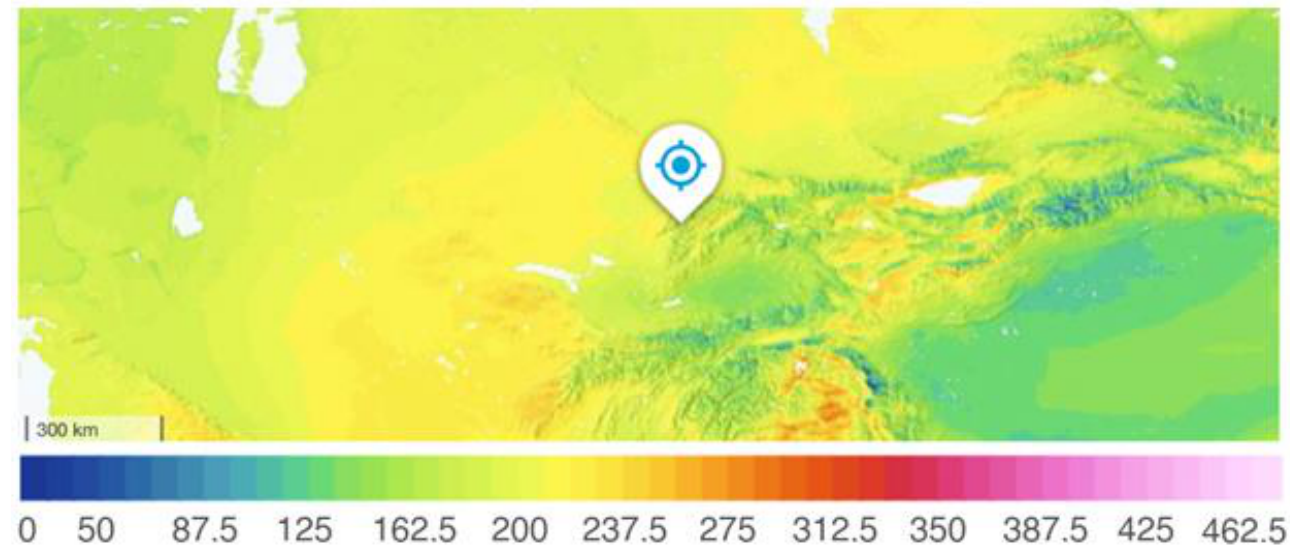
Figure 4. Map of direct solar radiation intensity, kW/m 2 in the area of the Pskem HPP (under construction).